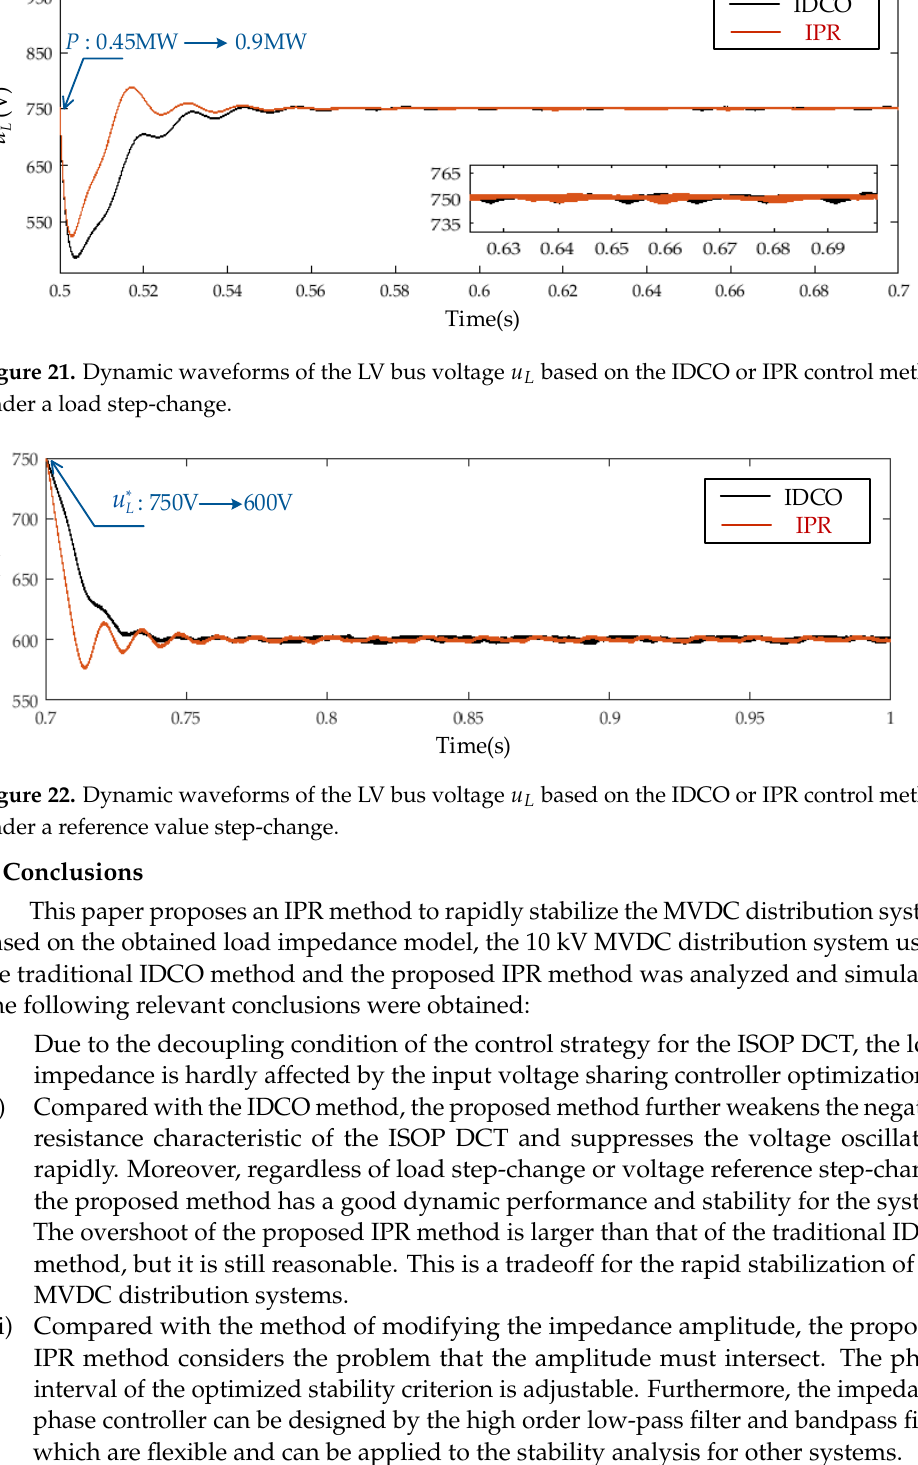
u based on the IDCO or IPR control L